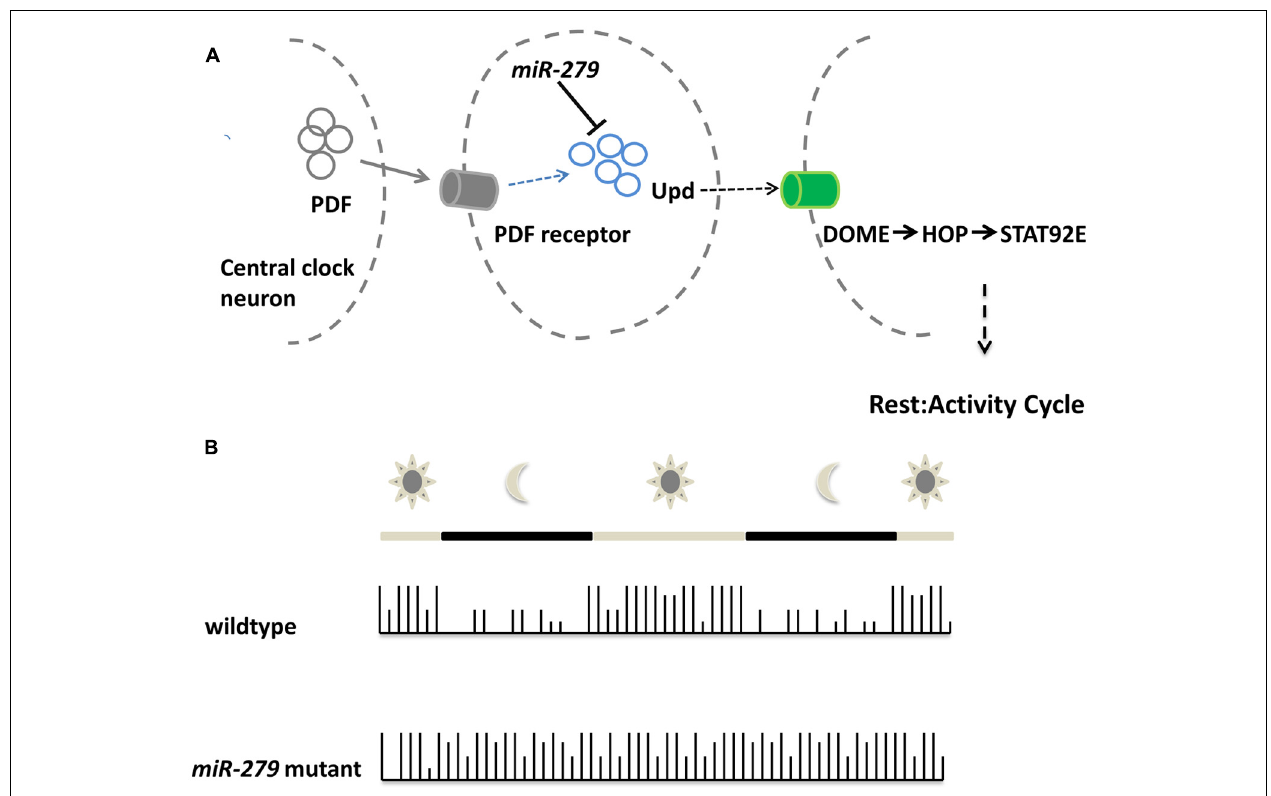
neurons which eventually assure the transition between rest and activity in the circadian rhythm of the fly. (B) During the day a wildtype fly shows alternating patterns of activity and rest. During daytime the fly shows high activity which is indicated by the high bars in the activity plot. During the night the rest cycle starts, indicated by low bars.The microRNA-279 mutant flies do not show rest/activity cycles anymore and show a overall activity throughout day and